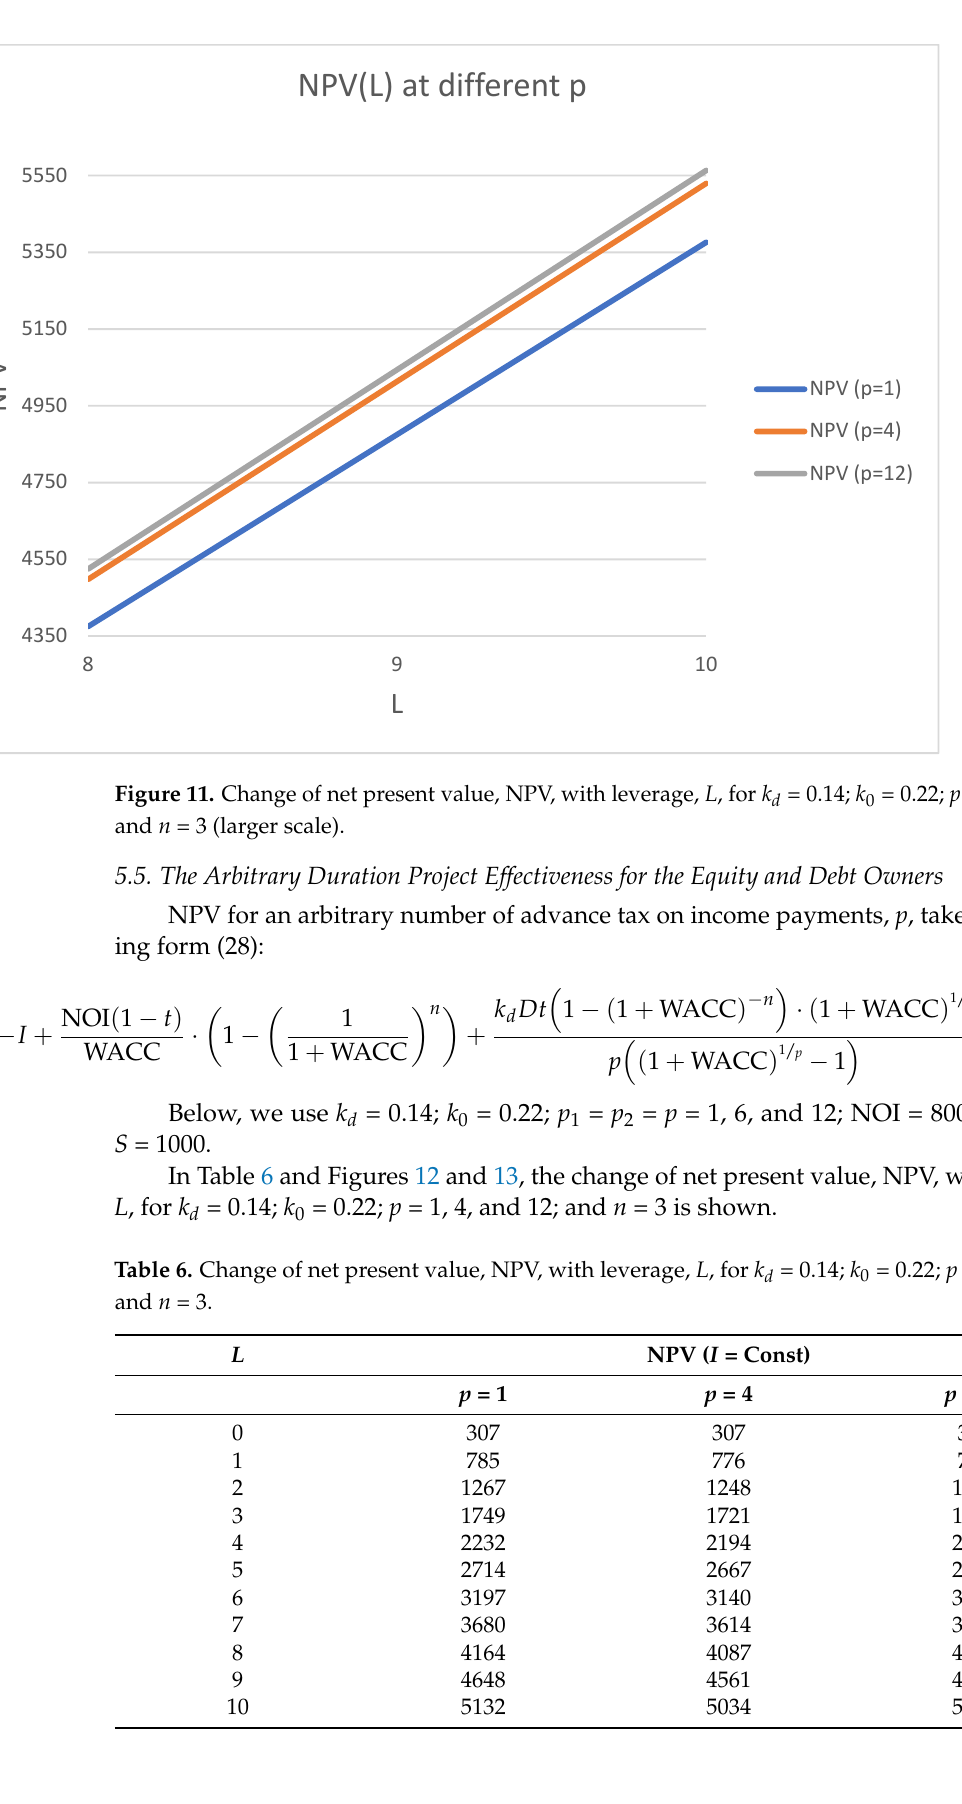
Figure 10. Change of net present value, NPV, with leverage, L , for k d = 0.14; k 0 = 0.22; p = 1, 4, and 12; and n = 3.